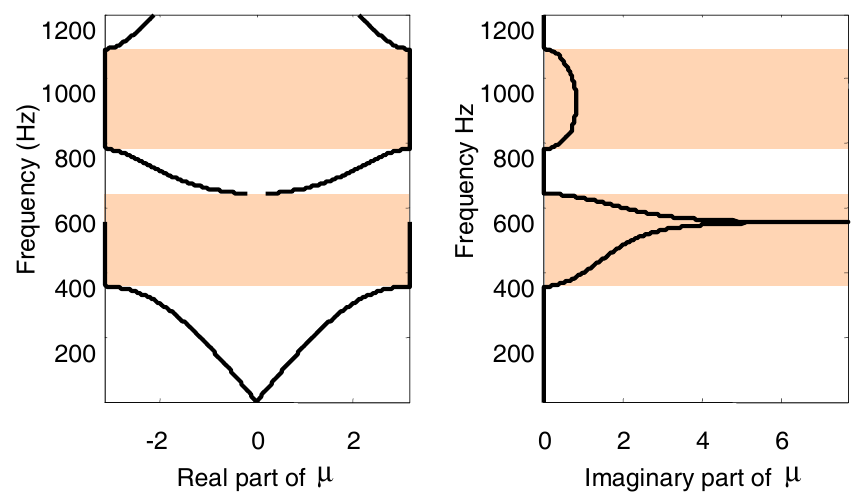
Figure 3. Acoustic band structure of an infinite periodic seawater pipe system.